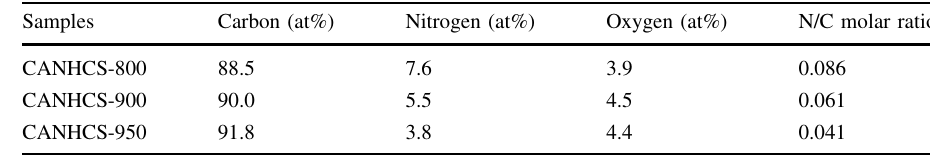
Table 3 Peak positions and relative compositions of different N functional groups obtained from the high- resolution N1s signals